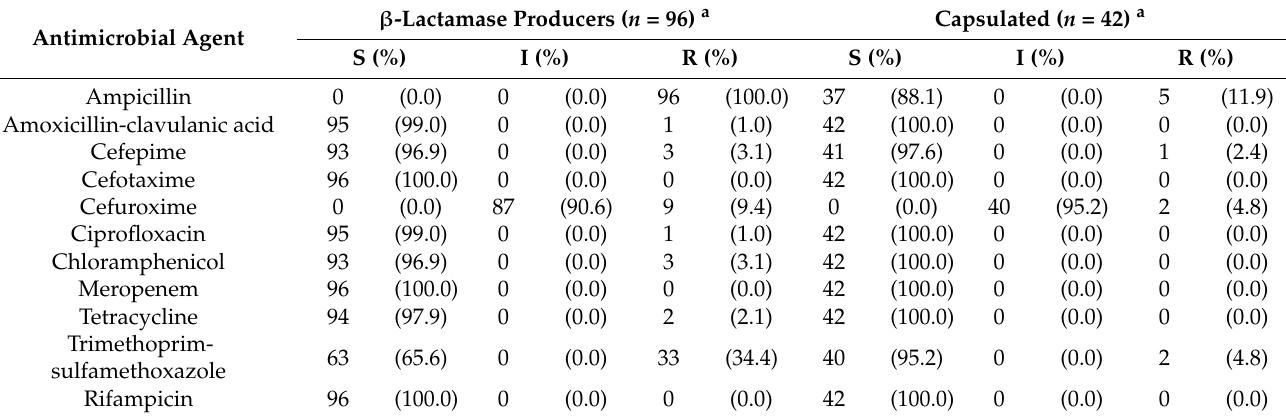
Table 3. Antimicrobial susceptibility of β -lactamase producers and encapsulated